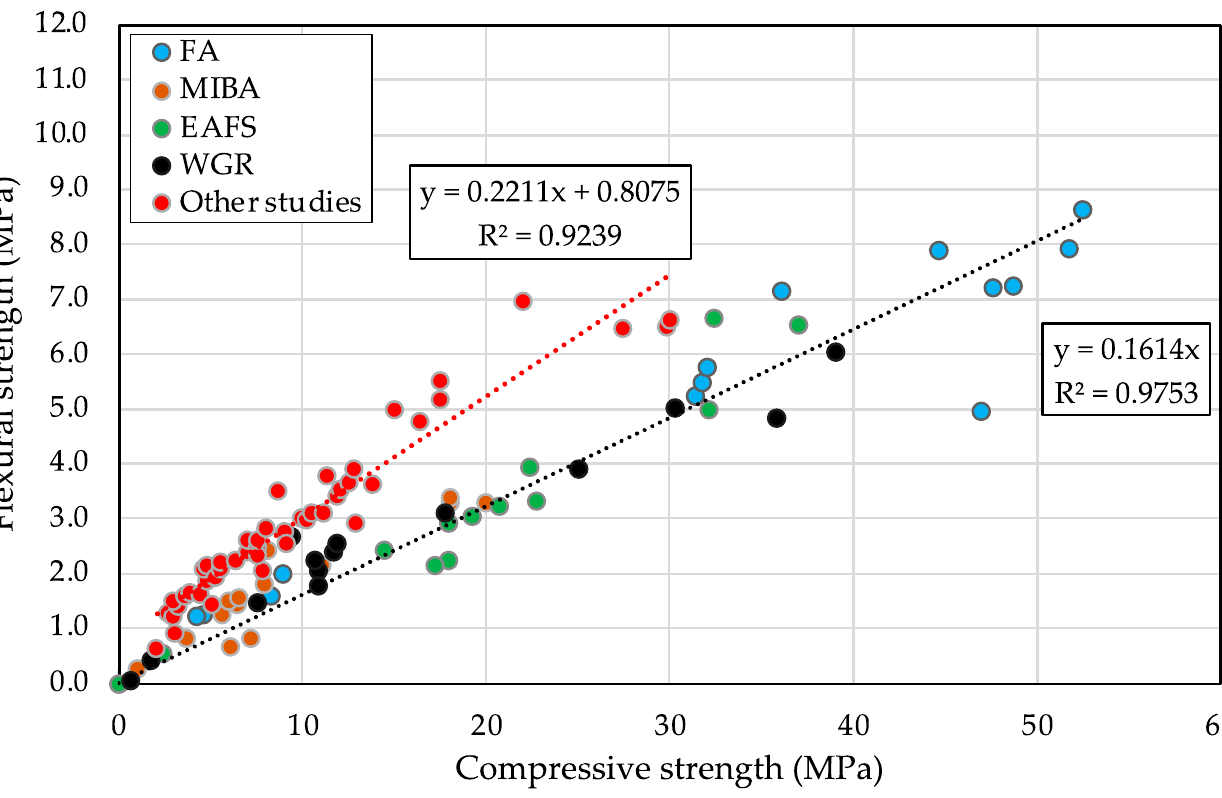
Figure 11. Flexural versus compressive strengths of all alkali-activated binders of this study compared to other studies from the literature [92–99] .